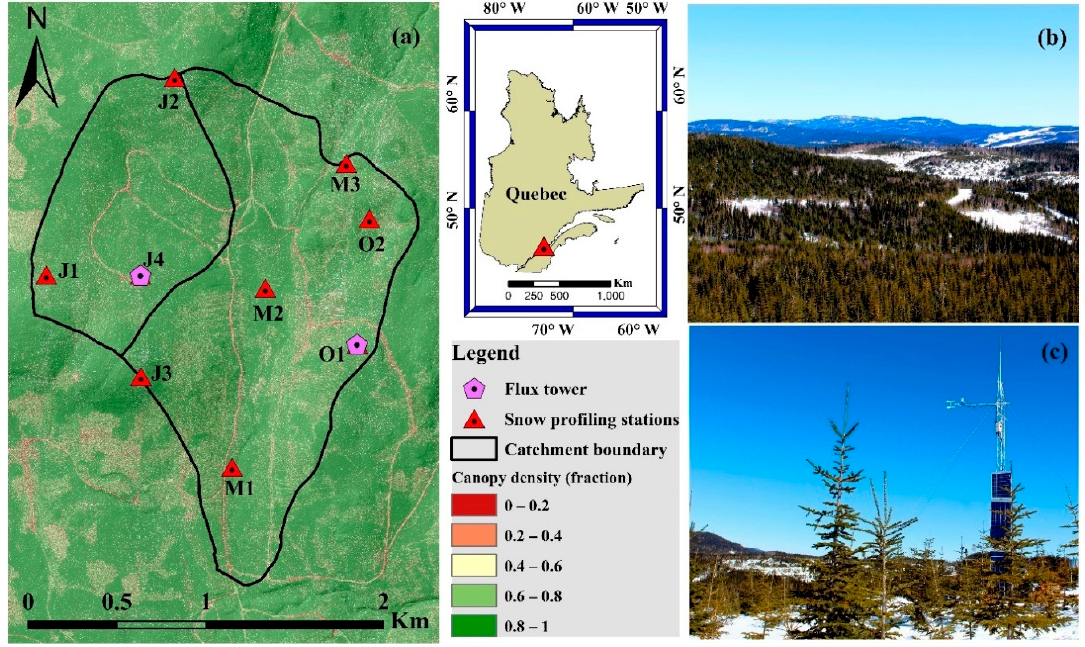
Figure 1. Study area. ( a ) Map of basin 7 within the “ Bassin Expérimental du Ruisseau des Eaux-Volées ” (BEREV), illustrating the locations of the snow-profiling stations where extensive snow water equivalent (SWE) sampling was performed during winters 2016–2017 (W1) and 2017–2018 (W2). Top right of the map: the location of BEREV in Quebec, Canada. ( b ) Flux tower near site O2. ( c ) Typical winter conditions at the BEREV.